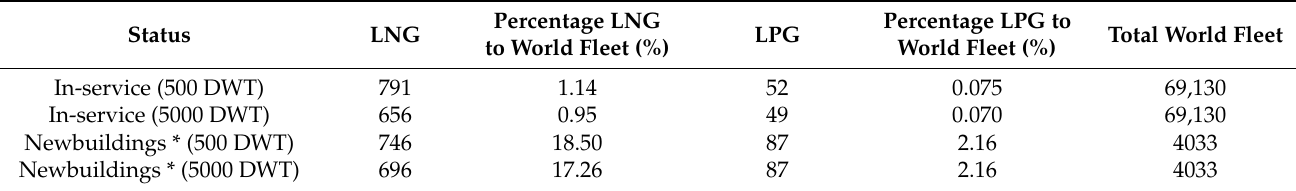
Table 3. Classification of vessels more than 500 DWT and 5000 DWT. LNG and LPG categories